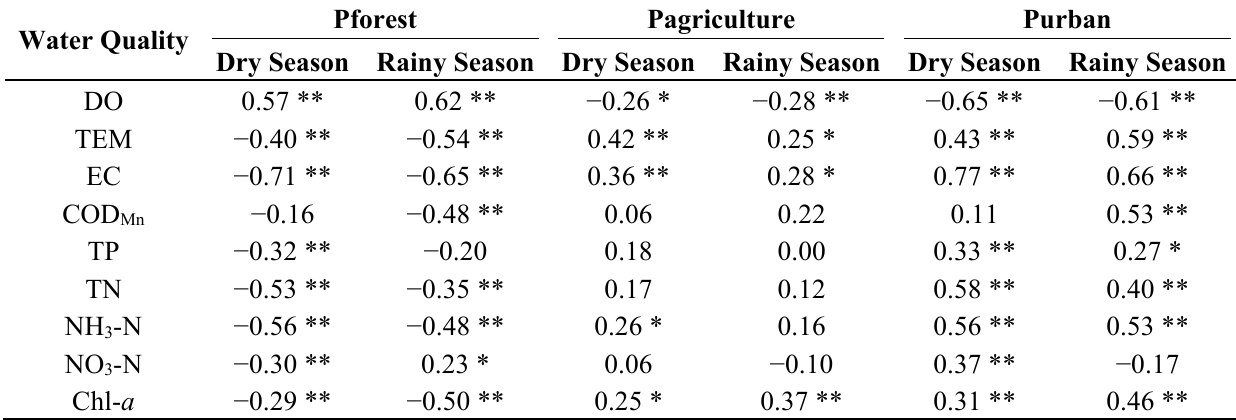
Table 5. Spearman correlation coefficients between water quality parameters and land use variables in the dry and rainy